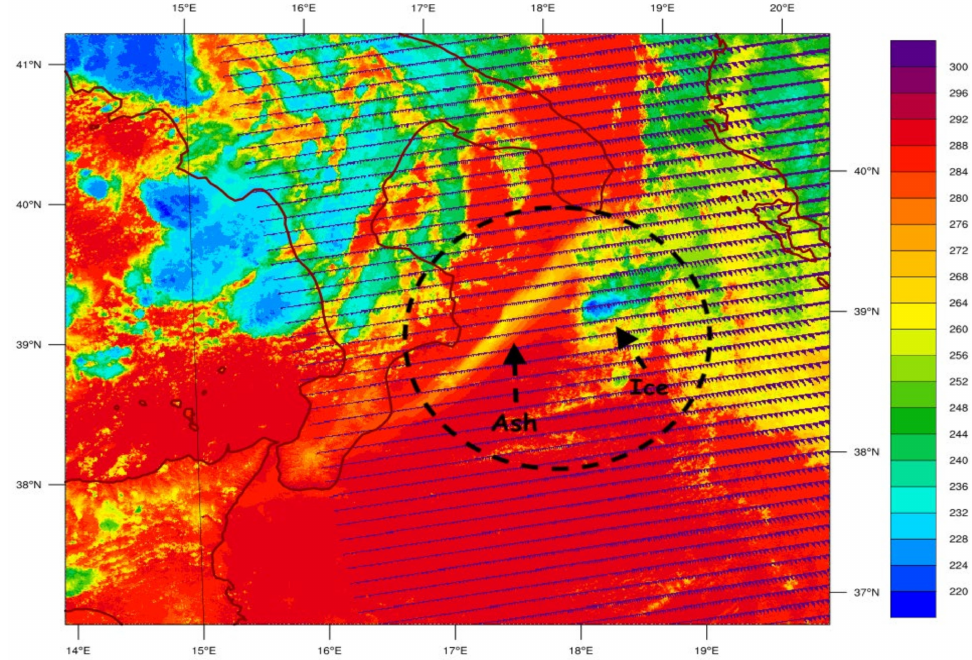
Figure 13. Brightness temperature (K) from NPP-VIIRS sensor I-5 Channel, at 1220 UTC of 23 Novem- ber. Circled dotted line denotes the ash and ice